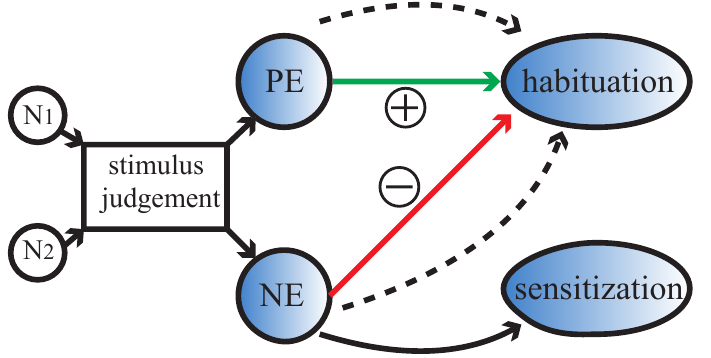
Figure 4. Diagram of circuit design. N 1 is the input signal. N 2 is the emotional signal. PE represents that the input signal N 1 is positive stimulus. NE represents that the input signal N 1 is negative stimulus.